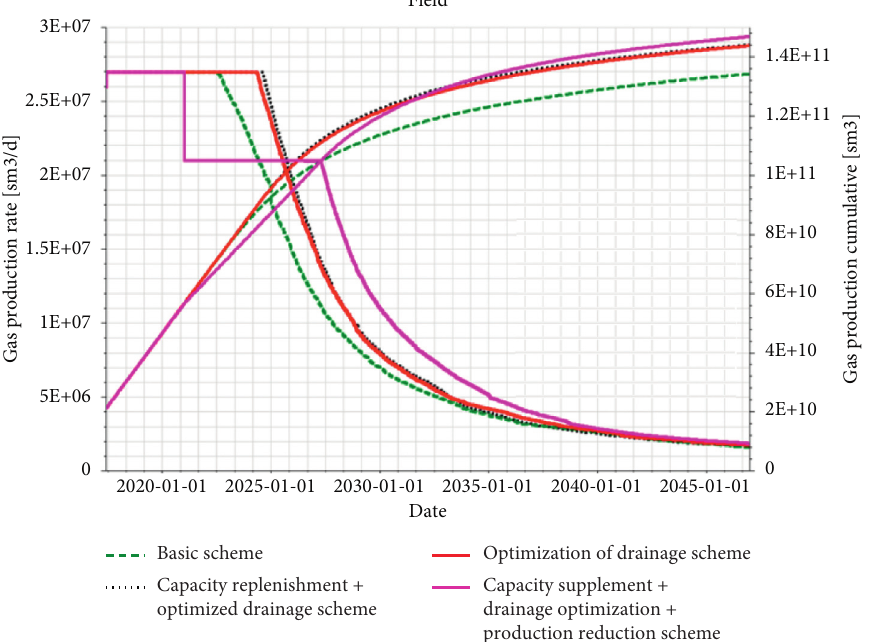
Figure 2: Comparison of production curves for various production